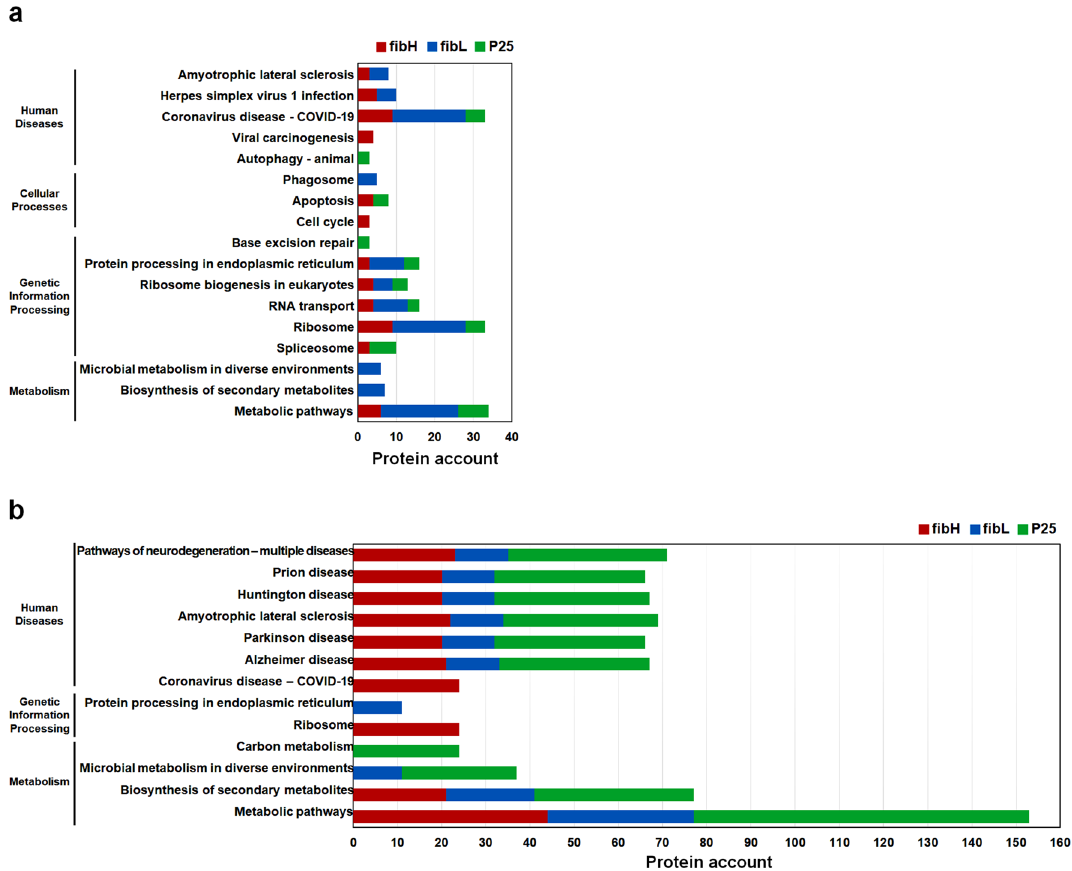
Figure 3. Top 10 KEGG pathways enriched in unique PIPs of each fibroin gene in M4 ( a ) and L5D5 ( b ). Red, blue, and green represent the PIPs of fibH , fibL , and P25 ,